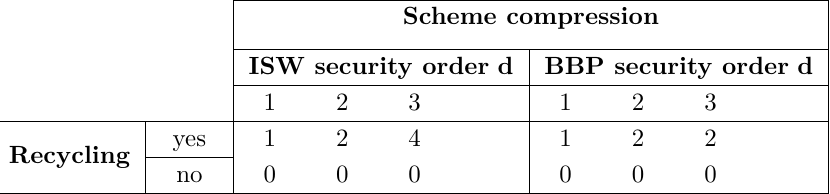
Table 2: Storage cost of optimized RRM schemes for n = 2 multiplications, assuming no storage is needed when recycling within a single multiplication (large register